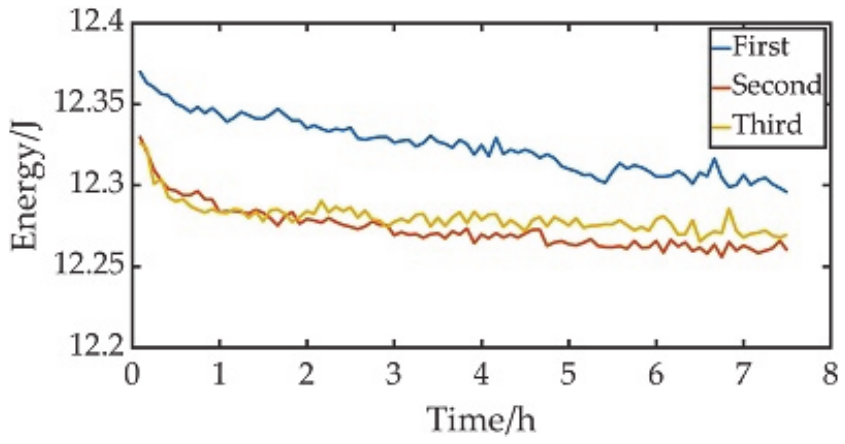
Figure 13. The output voltage of PD in Experiment 2.